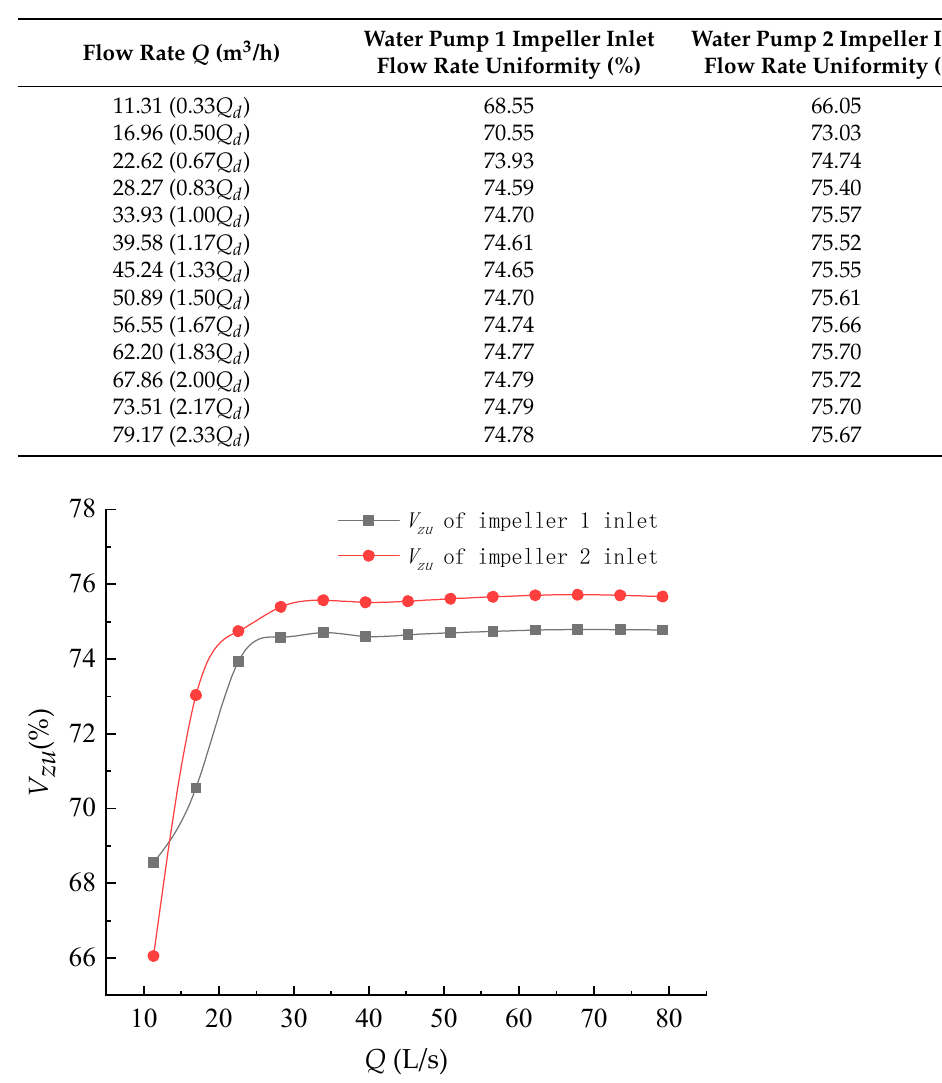
Table 2. Uniformity of impeller inlet flow rate at different flow rates.